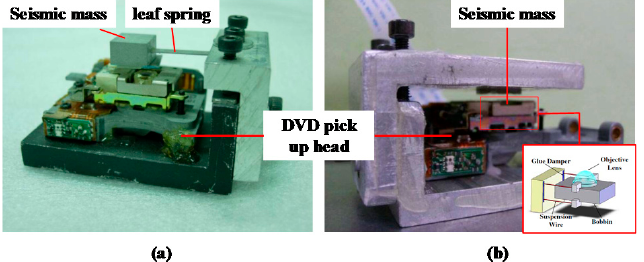
Figure 3. Cantilevered accelerometers: ( a ) leaf spring and ( b ) voice coil. Reprinted with permission from Ref. [21]. Copyright 2008 IOP.